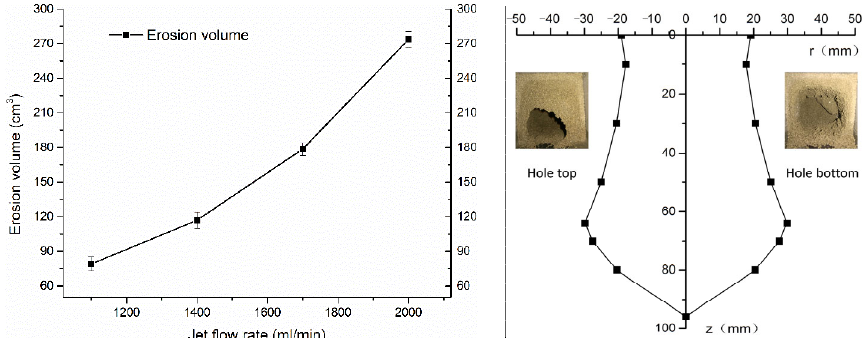
Figure 2. The influence of jet flow rate on erosion volume and the scatter plot of the erosion ‐ hole section of Run 3.